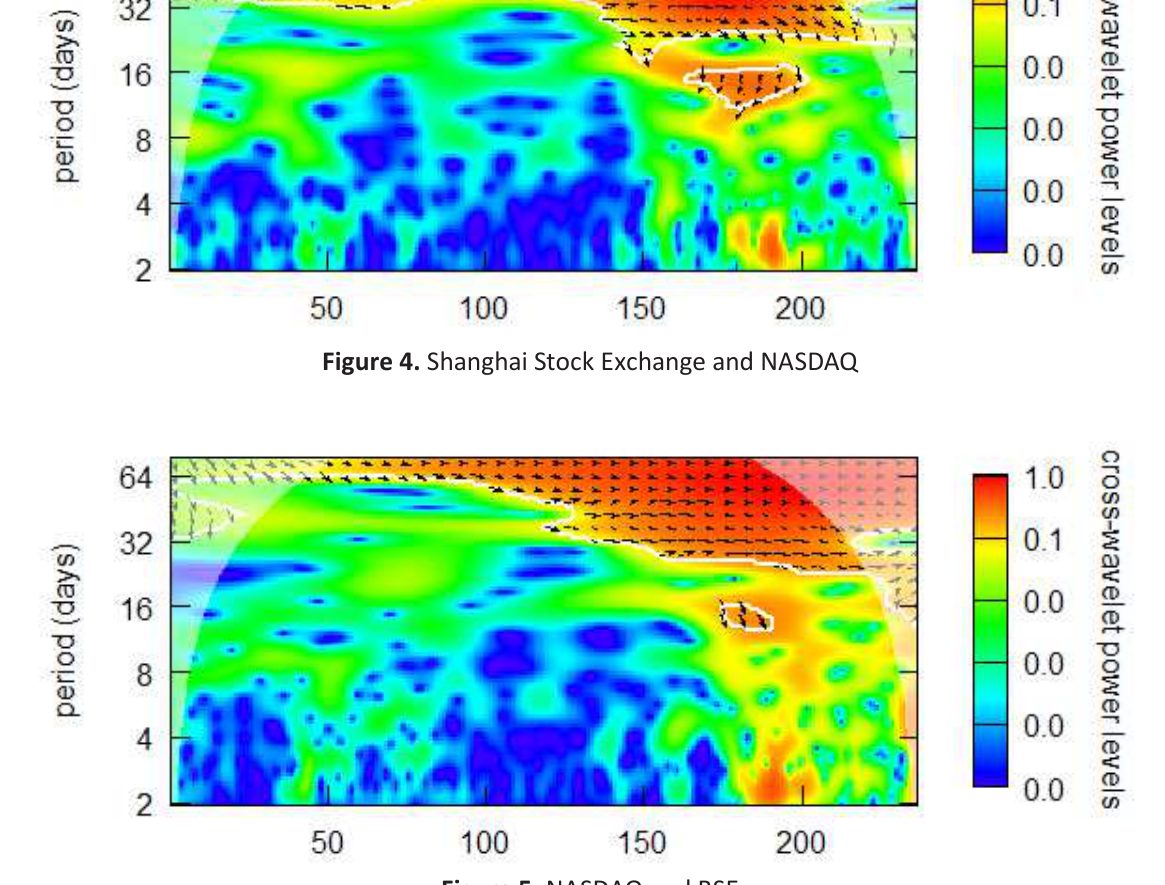
Figure 5. NASDAQ and